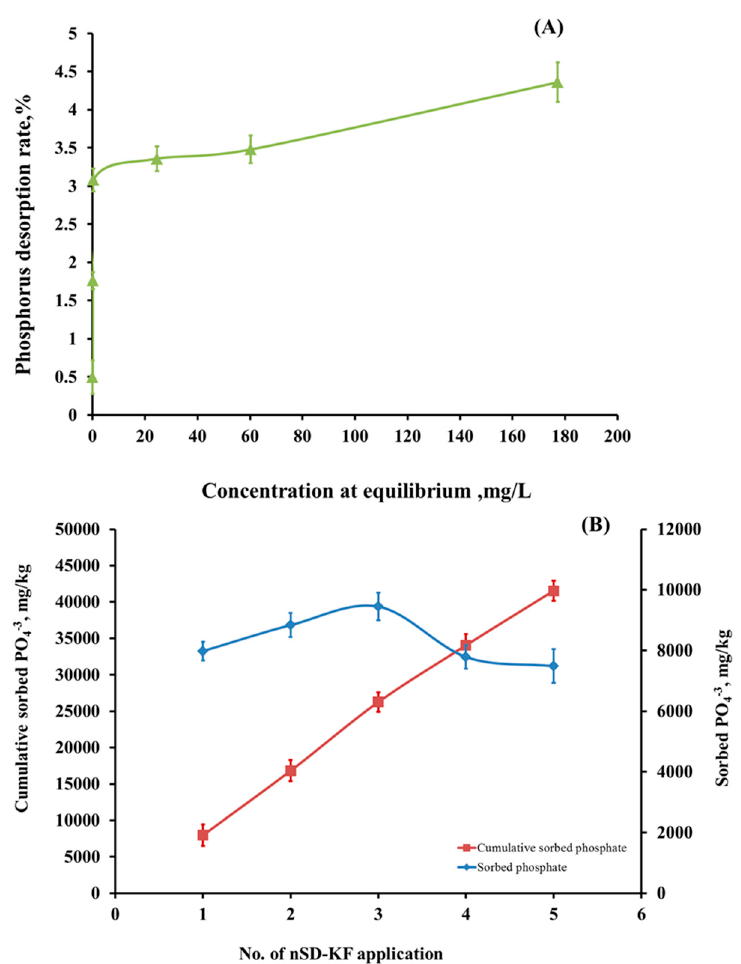
Figure 7. ( A ) Desorption of PO4-3 from nSD-KF loaded with different concentrations, ( B ) reusability after regeneration of the spent nSD-KF bio-sorbent (PO 4 − 3 = 100